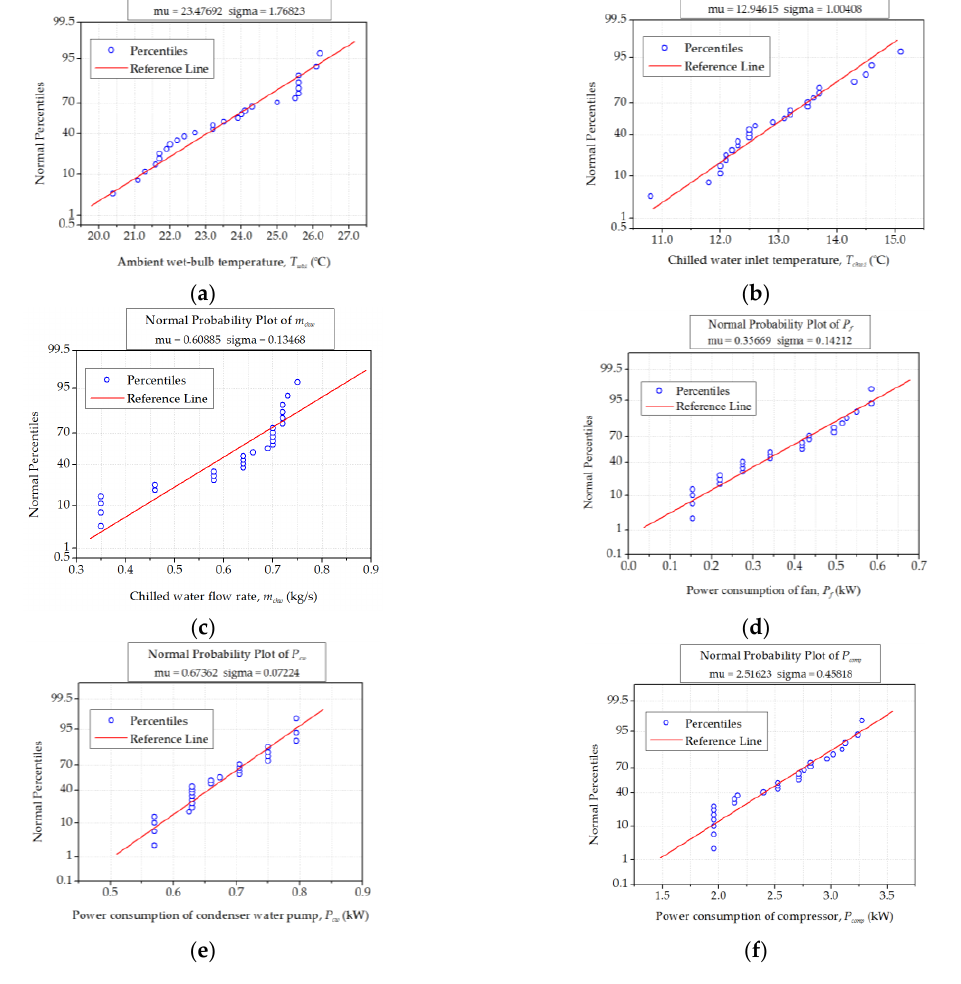
Figure 6. Normal probability plots of: ( a ) ambient wet-bulb temperature; ( b ) chilled water inlet temperature; ( c ) chilled water flow rate; ( d ) fan input power; ( e ) input power of condenser water pump and ( f ) compressor input power.